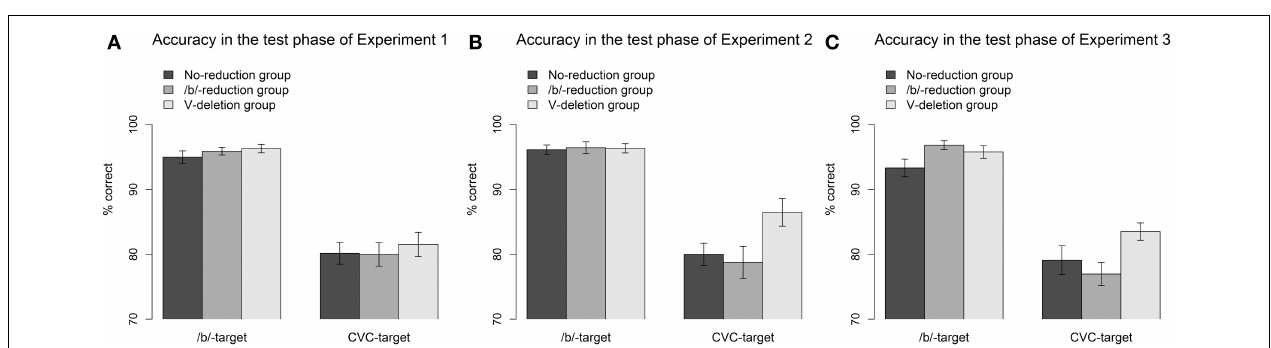
FIGURE 3 | Accuracy in % correct click responses and SEs for the reduced /b/-words (visual /b/-targets) and the vowel-deleted words (visual CVC-targets) in the test phases of Experiment 1 (A), Experiment 2 (B), and Experiment 3 (C).